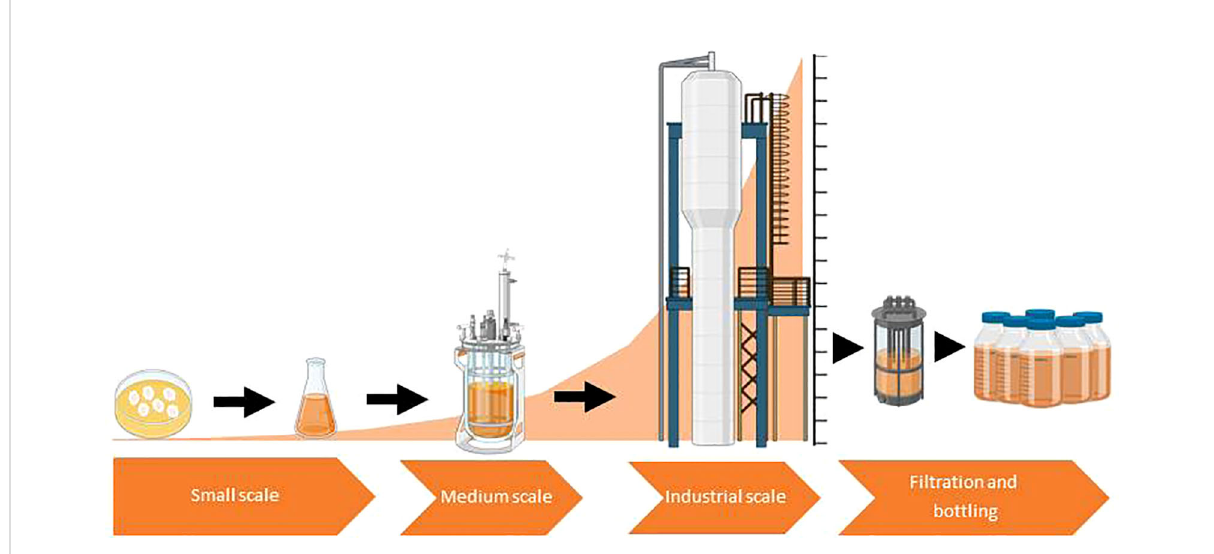
FIGURE 2 Scheme illustrating the scaling-up process of cell-free microbial culture fi ltrates (CFs) production to industrial level. Figure was created using